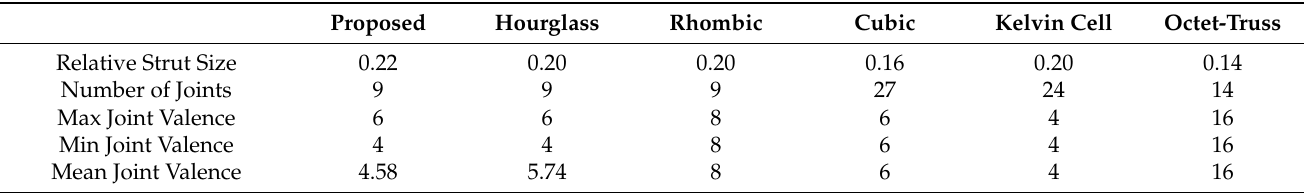
Figure 14. Topology strut angle distribution. Table 7. Lattice topology strut size and joint